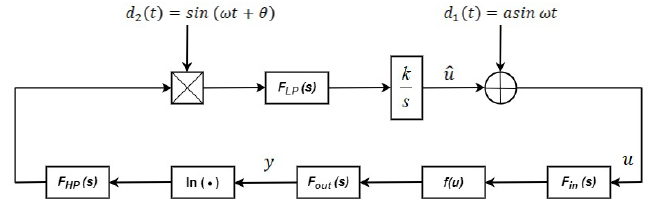
Figure 1. LP-ESC: Conventional ESC with log power feedback.